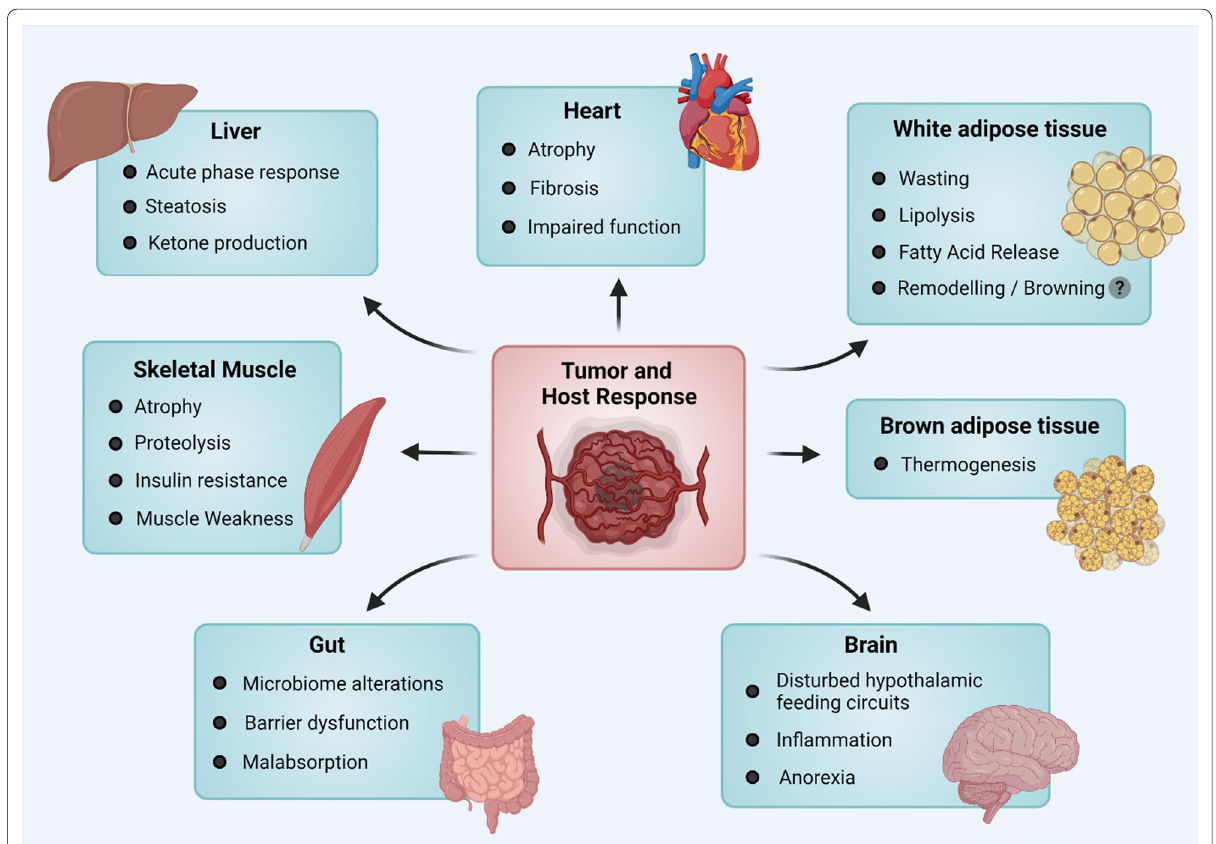
Fig. 1 Schematic highlighting cancer cachexia as a multi-organ syndrome: Cancer cachexia is regulated by signals that are released from the primary tumor, but also by mechanisms initiated by the host response. These pathways involve a wide range of organs, of which the main ones are indicated here. While the classical cachexia organs such as skeletal muscle and the fat depots have been in focus for quite some time, other major tissues such as the liver, the heart, the gut, and the brain are now known to be impacted or involved (as listed by the bullet points) in this syndrome, and are making their way into the